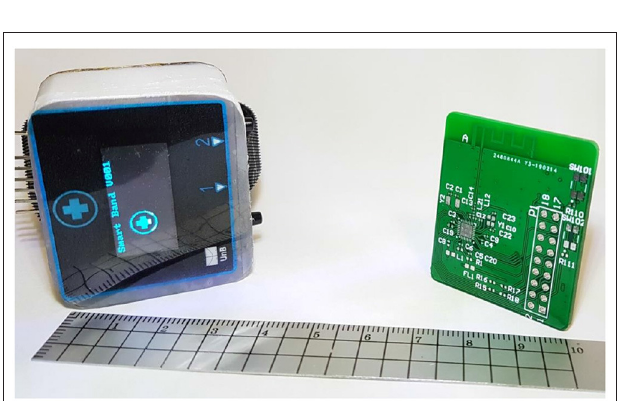
FIGURE 3 | Dimensions of the PCB and enclosure produced for the proposed MWHD device prototype.